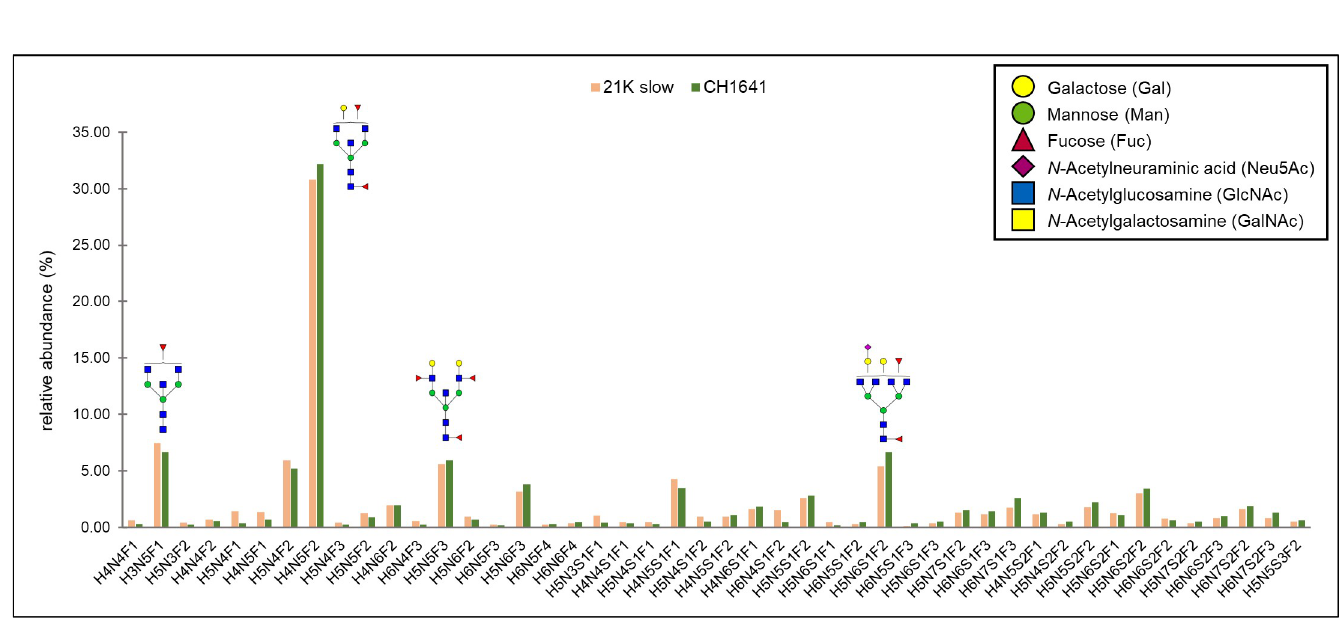
Fig 5. Relative abundances of N-glycans on N-184 peptide in both strains. In total, 46 structures are compared between the two strains analyzed. The most abundant structures (with relative abundance above 5%) are represented in the graph. Monosaccharide symbols marked in legend.